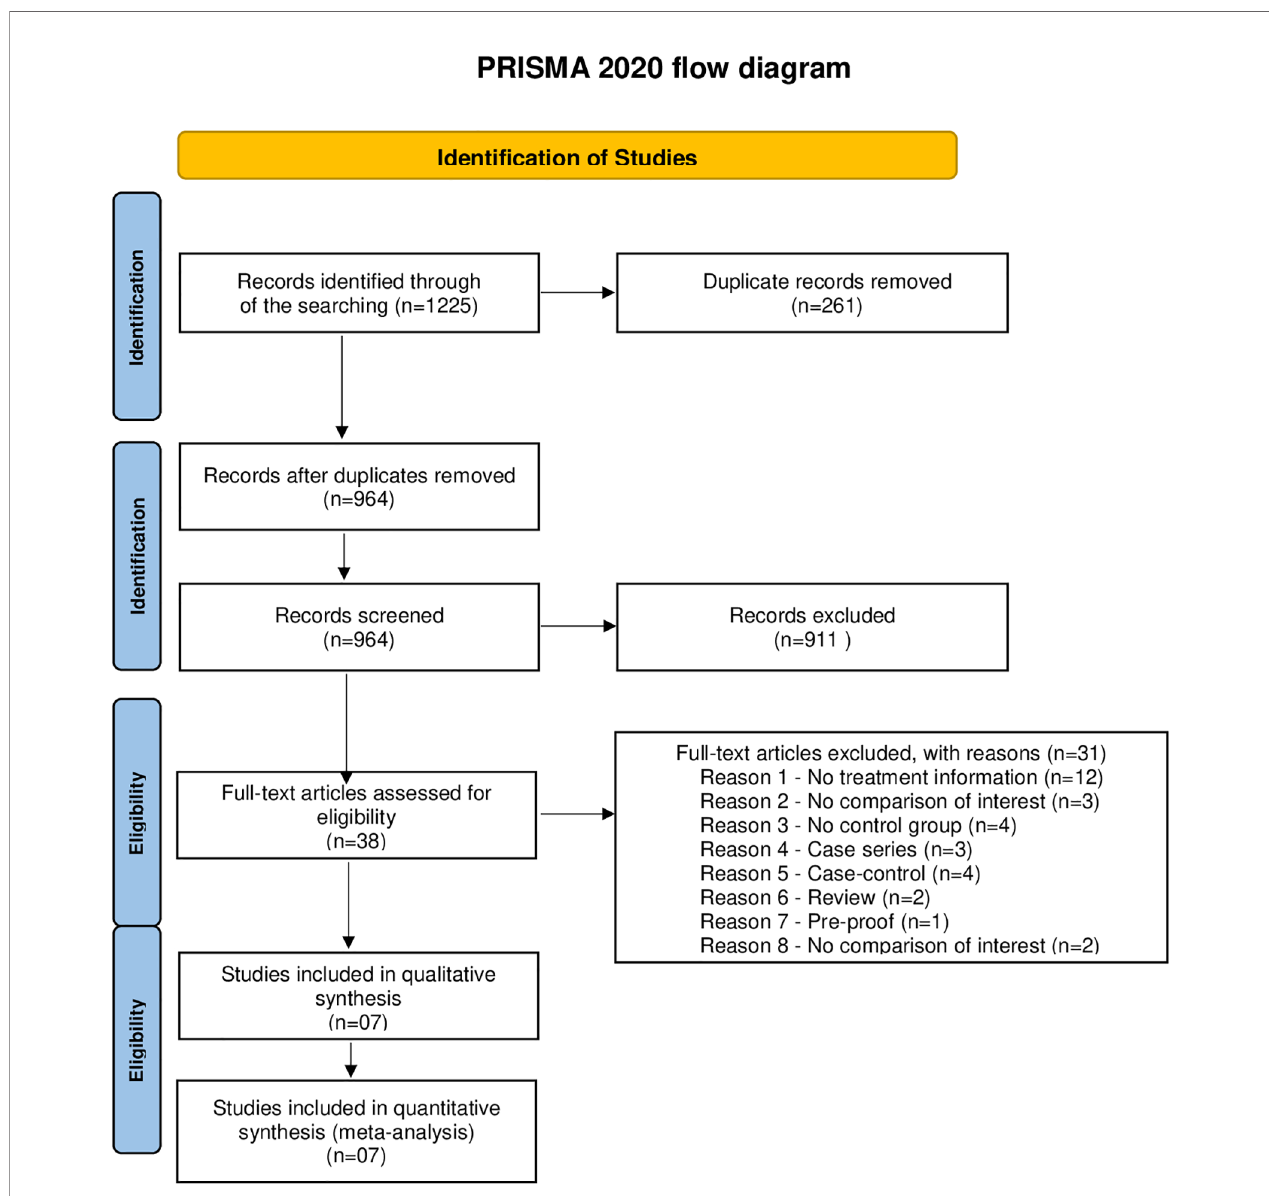
FIGURE 1 | Prisma Flow Diagram of Study